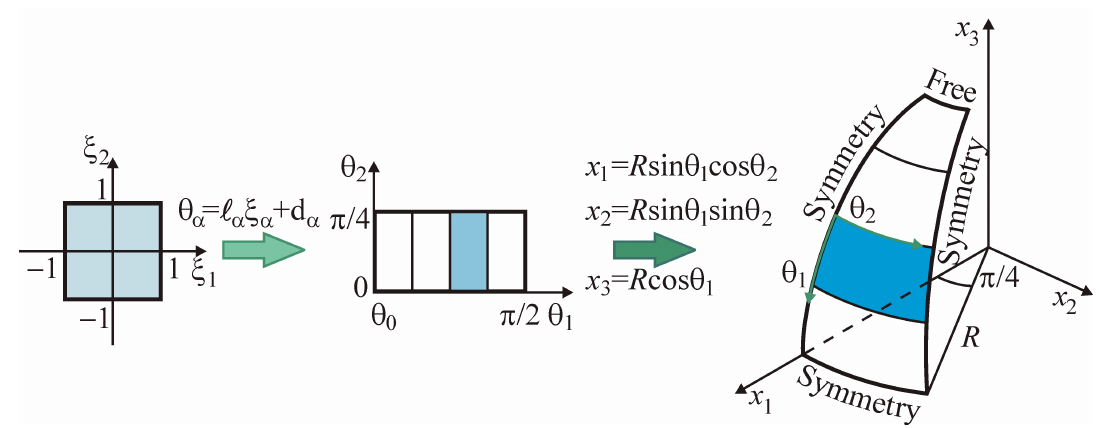
Figure 6: One sixteenth of the FGM piezoelectric spherical shell modeled by regular 4 n × 1 meshes with n = 1, 2, 4, 8, 12, 16 and 32